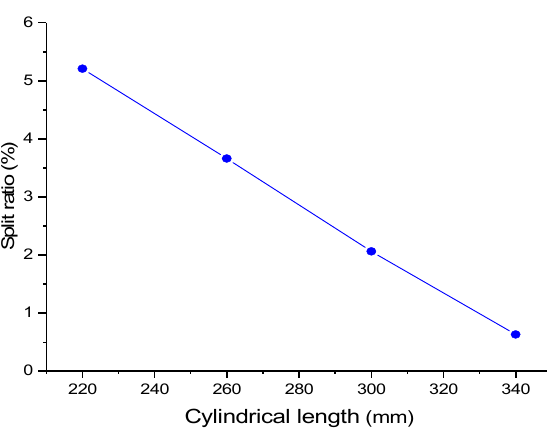
Figure 10. Effect of column height on the split ratio.